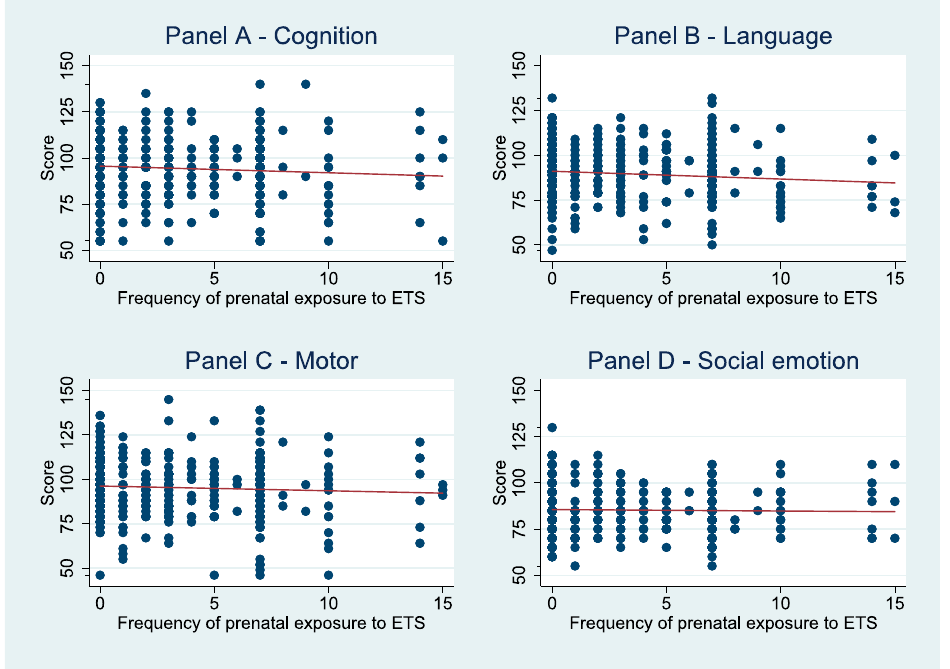
Figure A2. The association between BSID-III test score and the frequency of exposure to ETS during pregnancy.